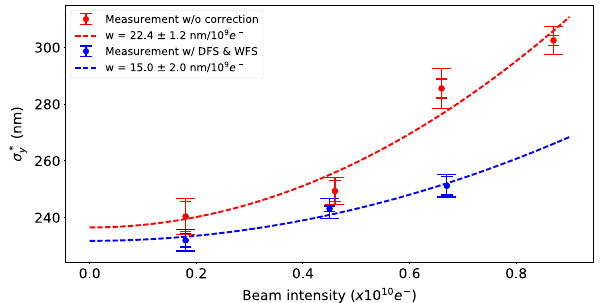
FIG. 7. Measured average vertical IP beam size ( σ (cid:1) y ) vs the beam intensity without correction and with DFS and WFS corrections. For each experimental data point the longer error bar shows the quadratic sum of the statistical and the systematic errors and the shorter error bar shows the systematic error. The lines show fits of Eq. (1).